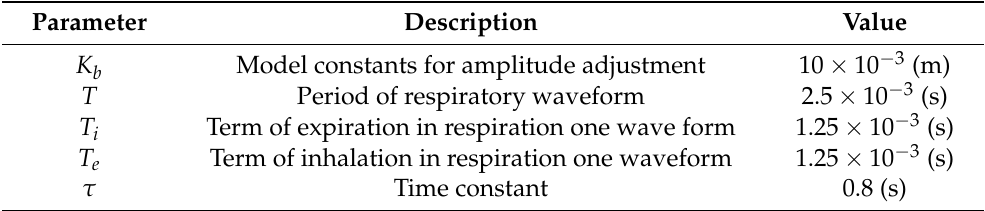
Table 1. Parameters used to generate the respiratory